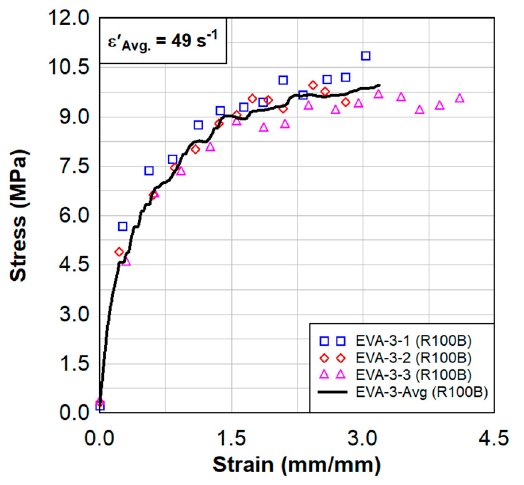
Figure 10. Dynamic tensile test results from three samples of radiated EVA − 3 specimens.